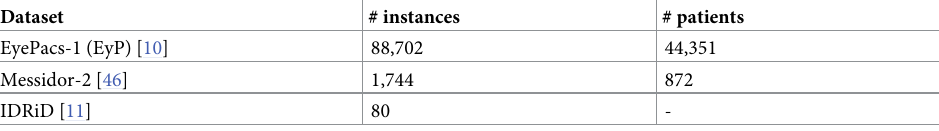
Table 1. Diabetic retinopathy datasets used for this